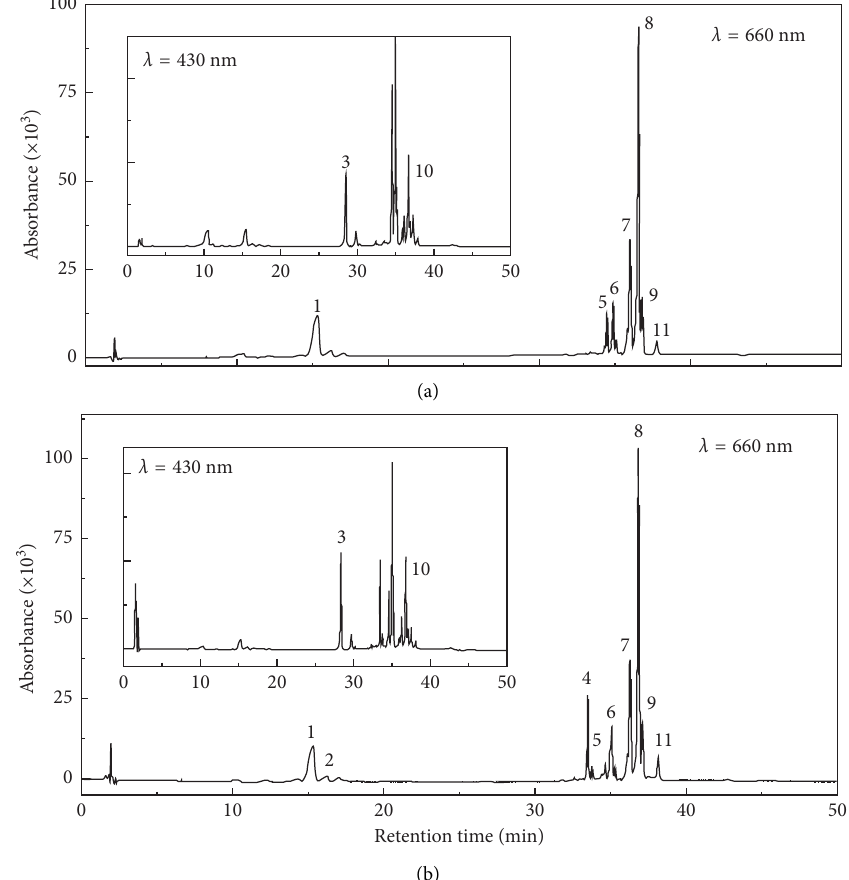
Figure 4: HPLC profiles for pigments extracted from dregs of green (a) and black (b) teas, primarily detected at 660nm for chlorophyll groups and 430nm (inset) for carotenoids. The peak number corresponds to the identified fractions as listed in Table